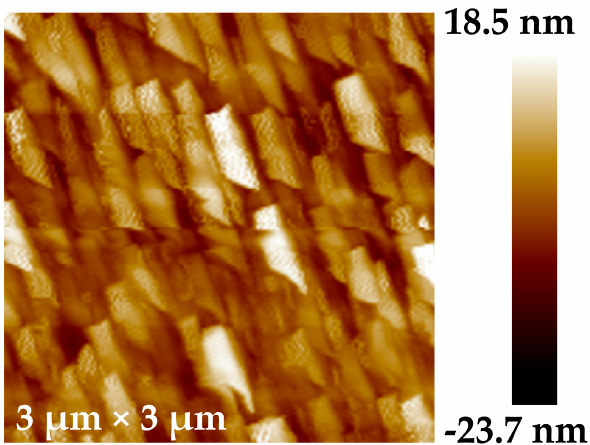
Figure 2. Atomic force microscopy (AFM) 3 μ m × 3 μ m topography image of CVD-EG.